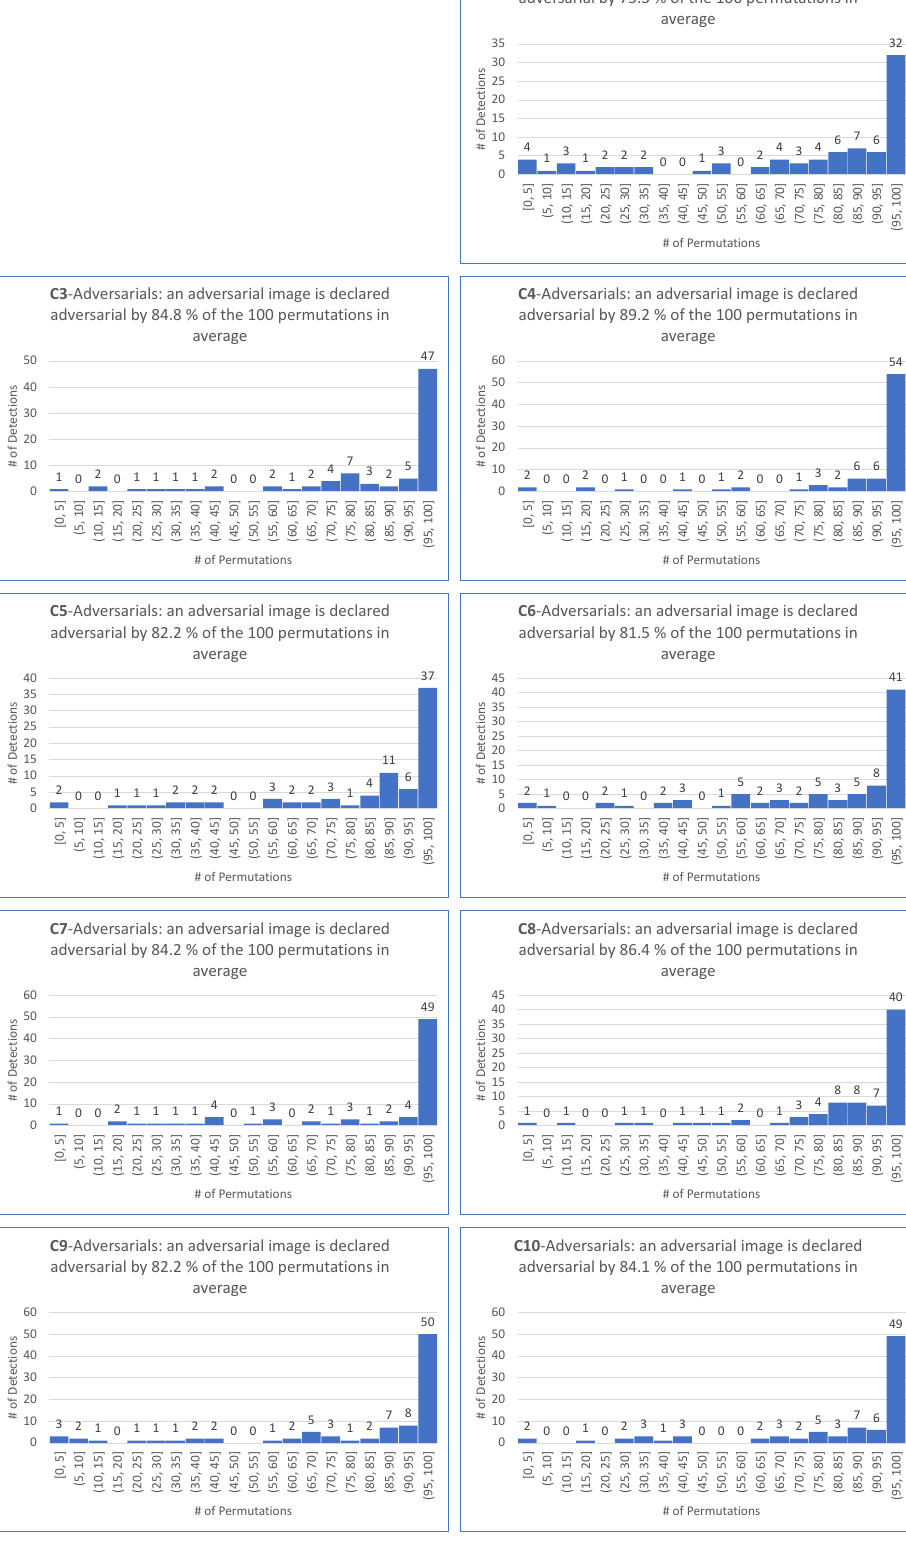
C2 -Adversarials: an adversarial image is declared adversarial by 75.3 % of the 100 permutations in